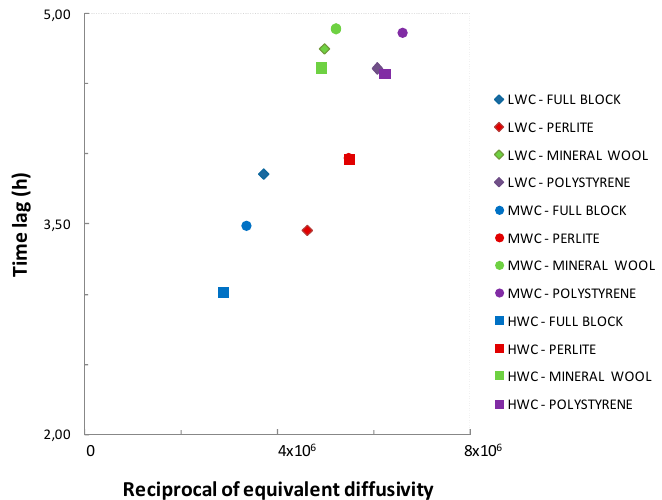
Figure 11. Time lag (in hours) vs. reciprocal of block equivalent diffusivity, all material combinations.